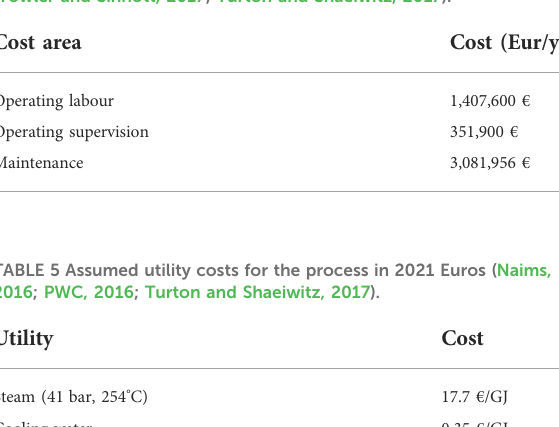
TABLE 4 Maintenance and labour costs for the process in 2021 Euros (Towler and Sinnott, 2017; Turton and Shaeiwitz, 2017).